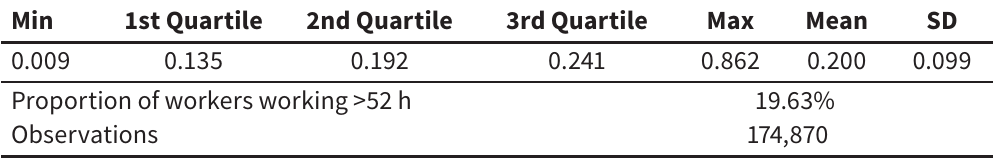
Summary statistics for policy